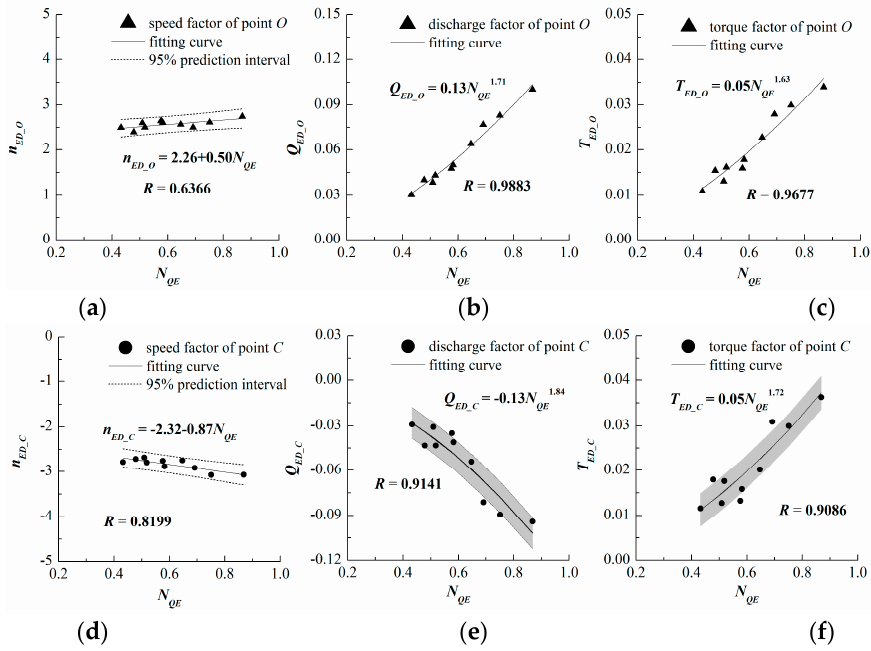
N and the characteristic parameters of point O and point C QE